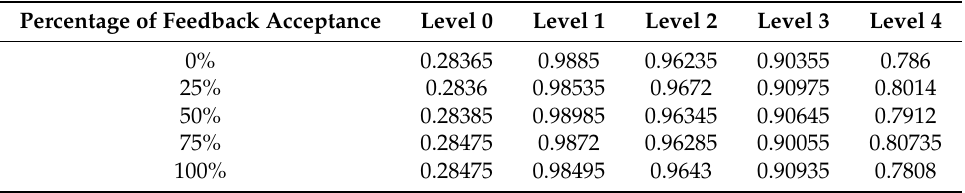
Table 7. User trust levels concerning efficiency when there is a high error rate at the lower level and the user is